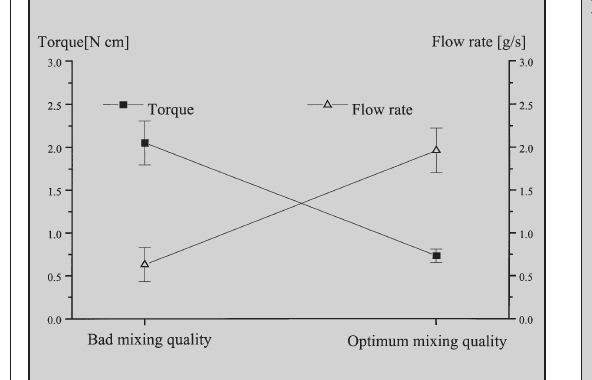
Figure 14 (left): Torque and outflow speed as a function of the mixing quality. Figure 15: Flow rate of different sample volumes in dependence of the particle size.